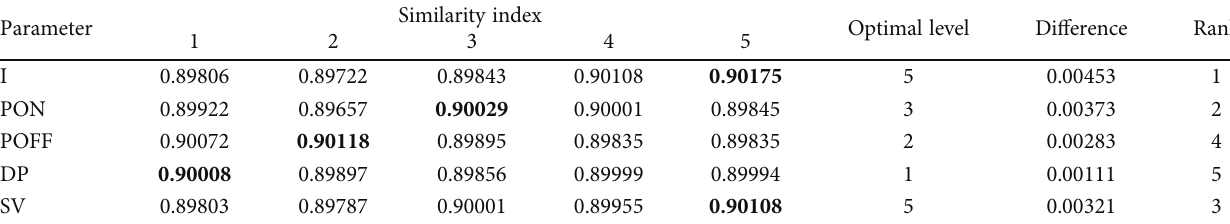
Table 7: Mean similarity index of each parameter at entry level.